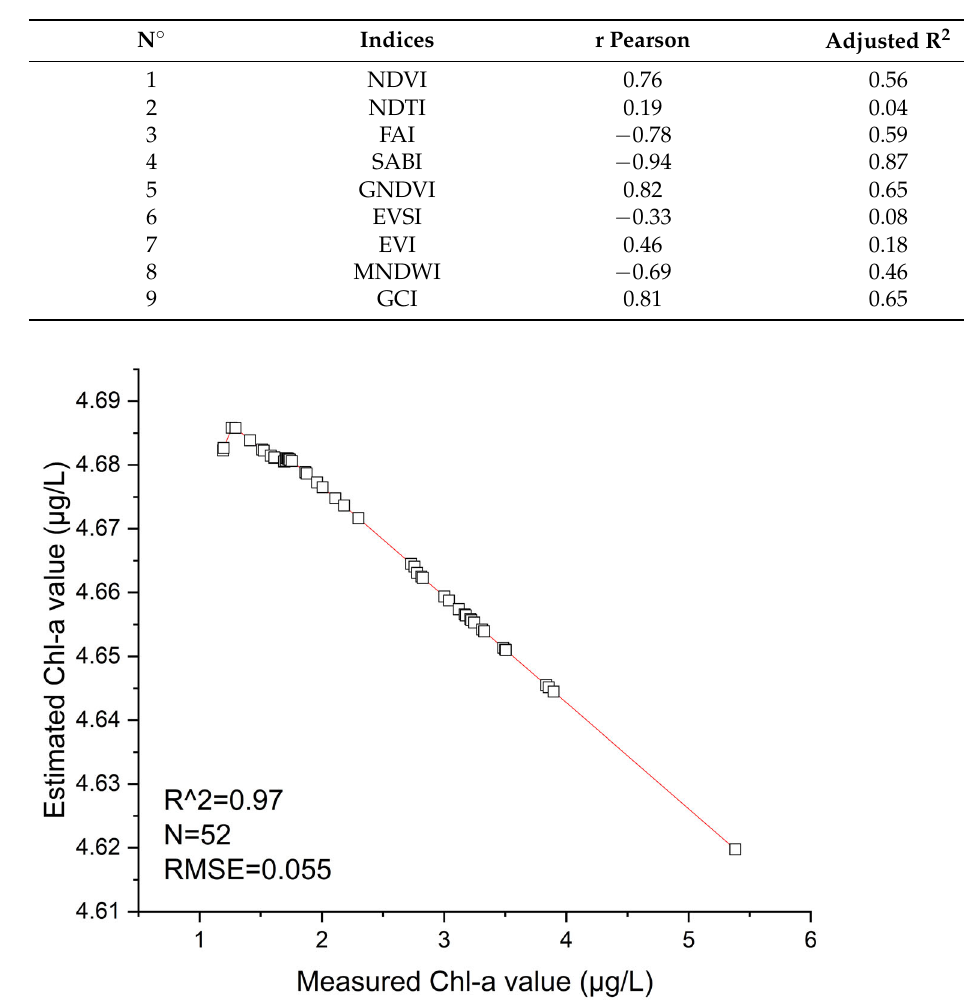
Table 5. Pearson correlation coefficient between the spectral indices and in situ measured Chlorophyll- a concentration.